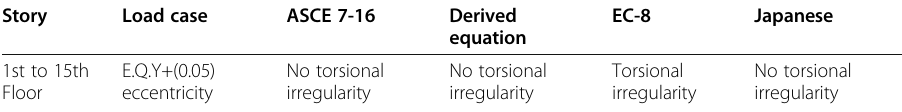
Table 10 Torsional irregularity check of 1st model due to ASCE 7-16, EC-8, Japanese, and derived equation